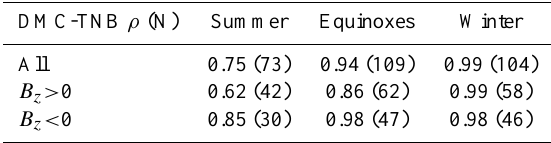
Fig. 4. The total (X+Y) 24-h power versus the K p index for TNB, DRV and DMC respectively. The equation of the best linear fit and the value of the correlation coefficient ρ are indicated inside the boxes. Table 2. Correlation coefficient ρ between the 24-h power at TNB and DMC, located at the same geographic latitude; the correspond- ing number of data points N are given in